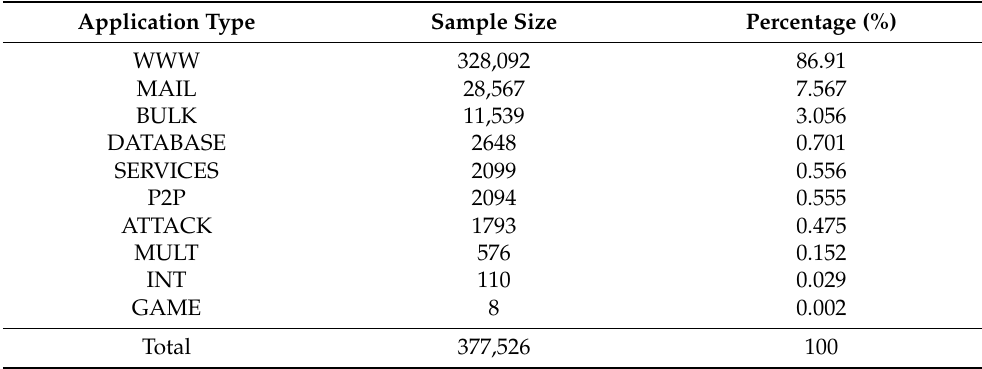
Table 1. Distribution of Moore